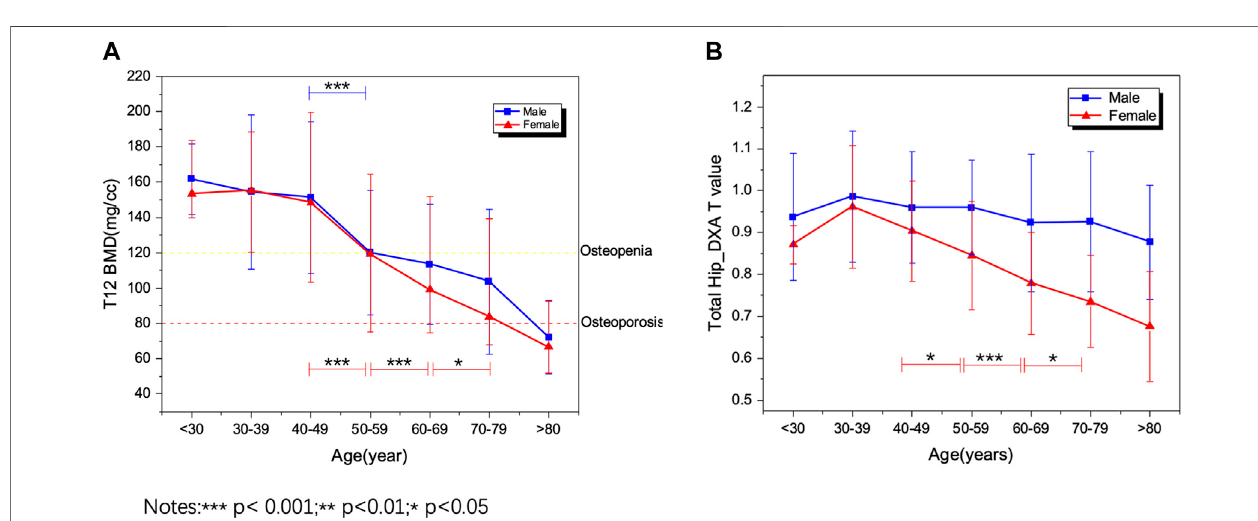
FIGURE 7 | PL-QCT and DXA BMD changes with age. (A) PL-QCT; (B) DXA.